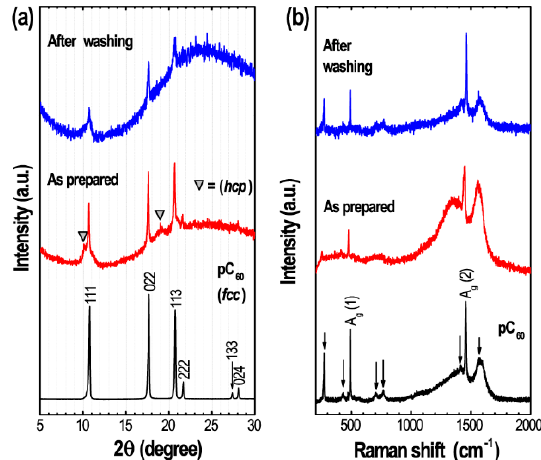
Figure 3. ( a ) Powder X-ray diffraction (pXRD) of pC 60 and self-assembled bitter-melon shaped fullerene C 60 crystals before and after washing; ( b ) the corresponding Raman scattering spectra recorded at 25 °C.